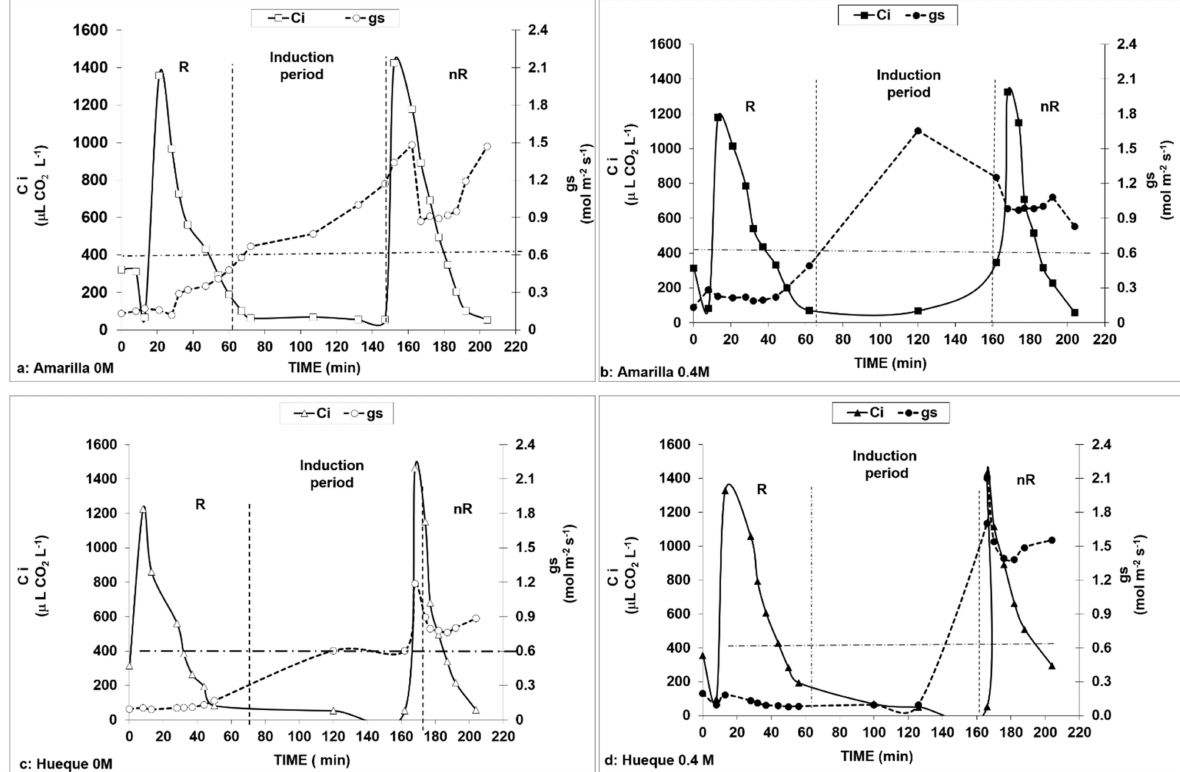
Figure 4. Curves of each ecotype used to determine the times necessary to induce stomatal opening. The continuous line represents the internal concentration of CO 2 (Ci), and the dotted line is stomatal conductance. The line parallel to the x -axis represents the minimum limit required for open stomata. Lines parallel to the y -axis define the measurement periods. R—measurements with stomatal constraints; nR—measurements with no stomatal constraints. The induction period corresponds to the time interval required to induce stomata opening by applying a concentration of 50 µ L CO 2 L − 1 . Internal concentrations correspond to IRGA measurements with respect to the application of a specific environmental CO 2 concentration, applied according to the time sequences described in Table